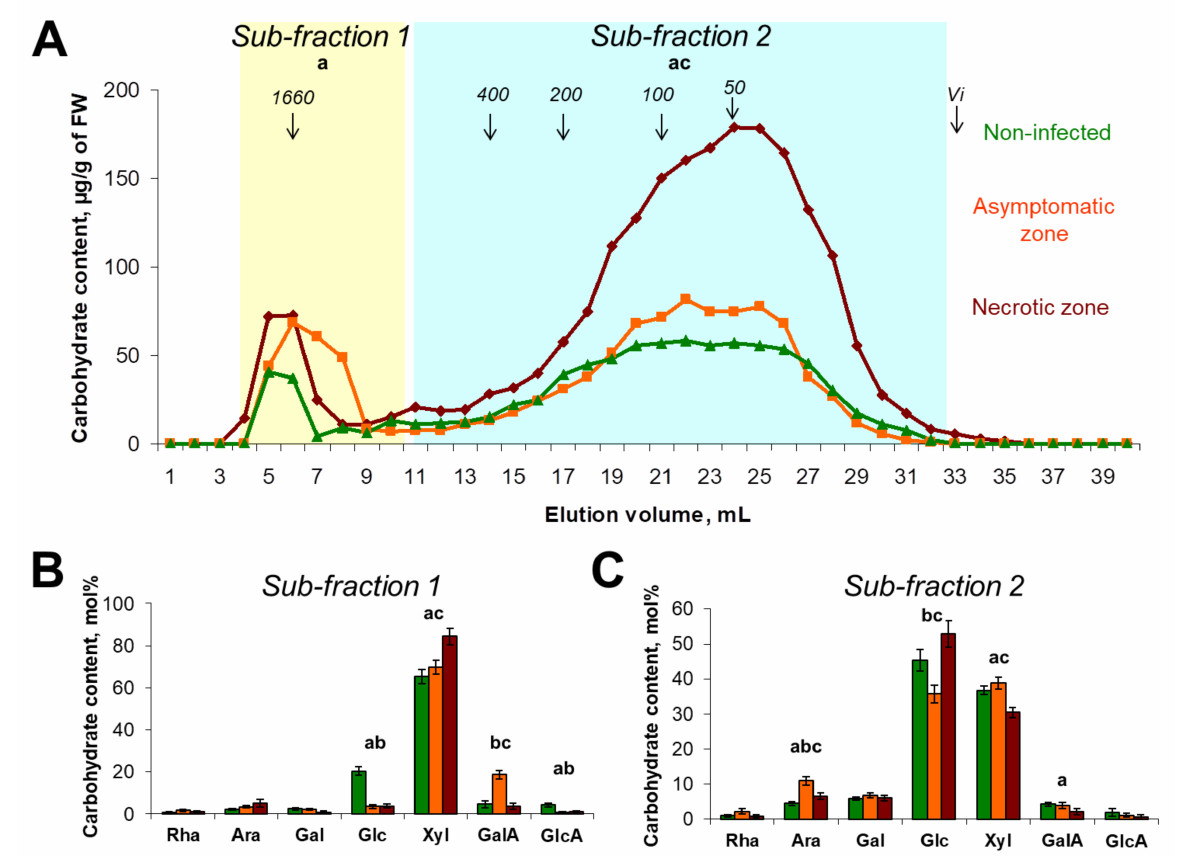
Figure 4. The molecular weight distribution and monosaccharide composition of polysaccharides extracted with 4M potassium hydroxide (KOH) from the plant cell walls isolated from stems of control non-infected (green) or Pectobacterium atrosepticum -infected (orange and brown) potato plants: asymptomatic zone (orange) and necrotic zone (brown). ( A ) Elution profiles were obtained using size-exclusion chromatography on a Sepharose CL-4B column; pullulans were used as molecular weight markers; Vi—inclusion volume; values are the means (per g of fresh weight, FW) of three biological replicates. Monosaccharide composition was analyzed in different sub-fractions, i.e., ( B ) sub-fraction 1 and ( C ) sub-fraction 2, which are marked on elution profiles following hydrolyzation with trifluoride acetic acid; values are the means ± SD (mol%) of three biological replicates. Small letters a, b, and c point to the significant difference in the carbohydrate content within a particular sub-fraction (panel A) or in mol% content of a particular monosaccharide (panels B, C) (Mann–Whitney two-sided test, p < 0.05): a—control vs. necrotic zone; b—control vs. asymptomatic zone; c—asymptomatic zone vs.